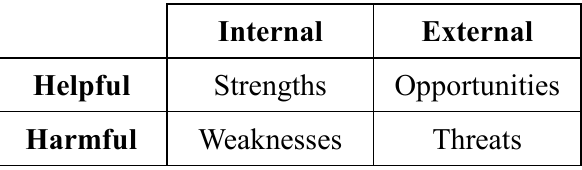
Figure 1. SWOT matrix.